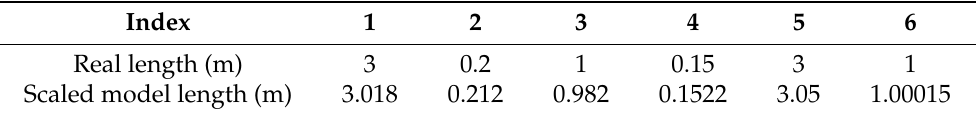
Figure 9. Edge pairs we choose in Experiment 1. Table 1. The scaled model length and actual length of edge pairs selected in Experiment